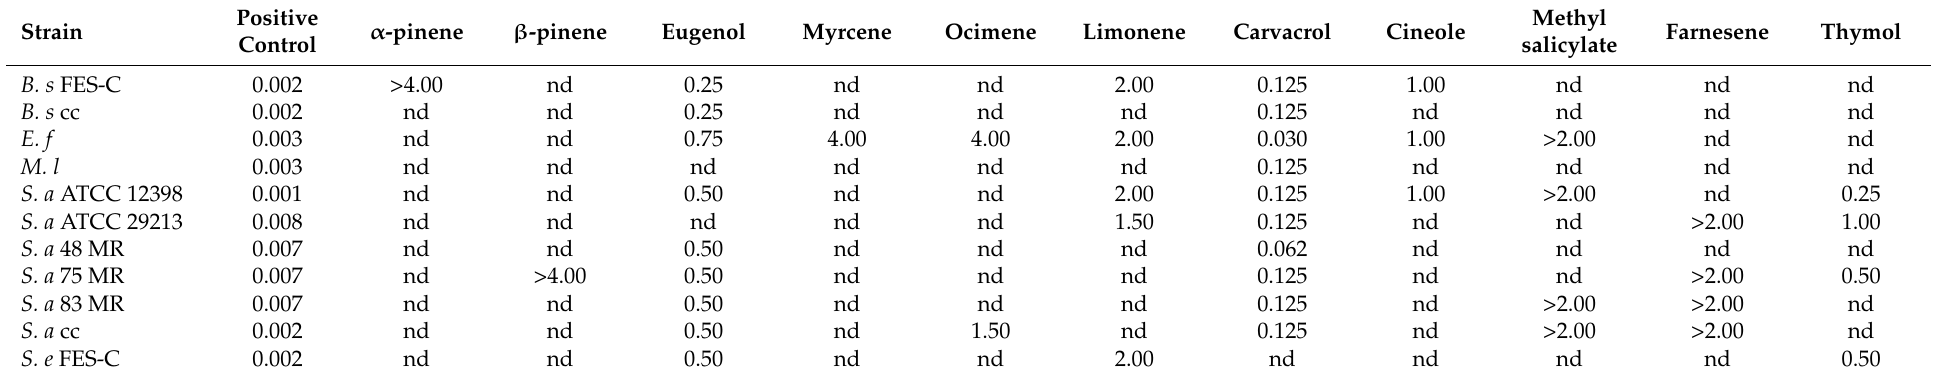
Table 4. Minimal inhibitory concentrations of some compounds in Gram-positive strains.